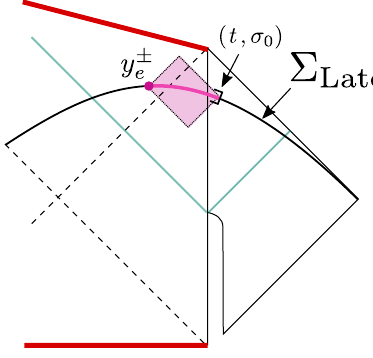
Figure 5 . The spacetime diagram describing the coupling of the black hole to the bath, the energy pulse coming from the moment they are coupled, the formation of the black hole and its subsequent evaporation. We pick some late time nice slice (cid:6) Late and we compute the entanglement wedge for what is to the left of (cid:27) 0 . This contains only a portion of the time slice in the interior. We have also displayed the Wheeler de Witt patch, or causal domain of dependence that describes the full entanglement